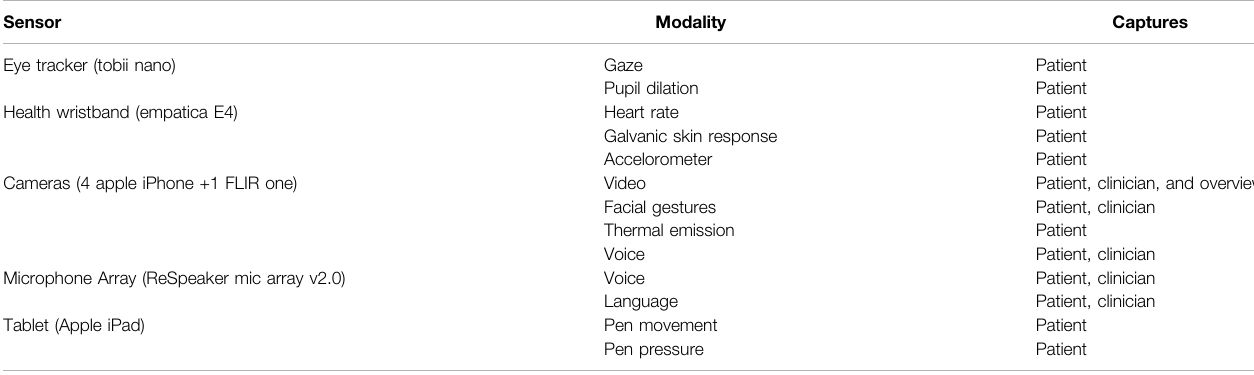
TABLE 1 | A summary table of what modalities each sensor captures.